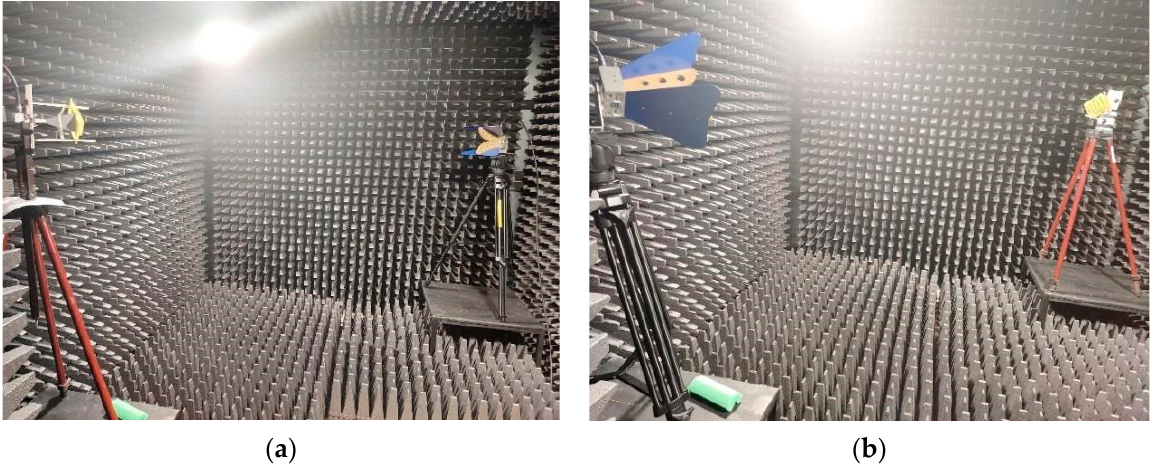
Figure 13. Measurement setup in the anechoic chamber for radiation pattern ( a ) and polarization pattern ( b ).